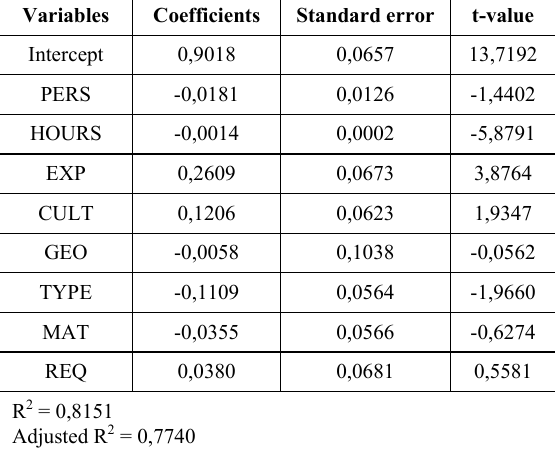
Table 3: Regression results